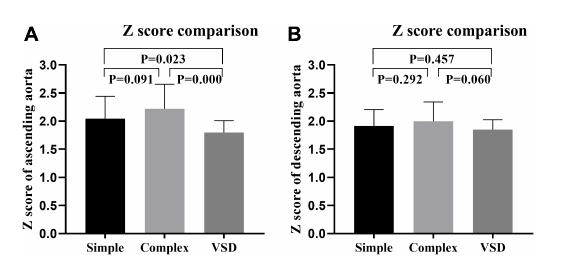
FIGURE2 Z scores of the ascending (A) descending aorta (B) in the simple coarctation of the aorta (CoA) group, the complex CoA group, and the ventricular septal defect (VSD) group were